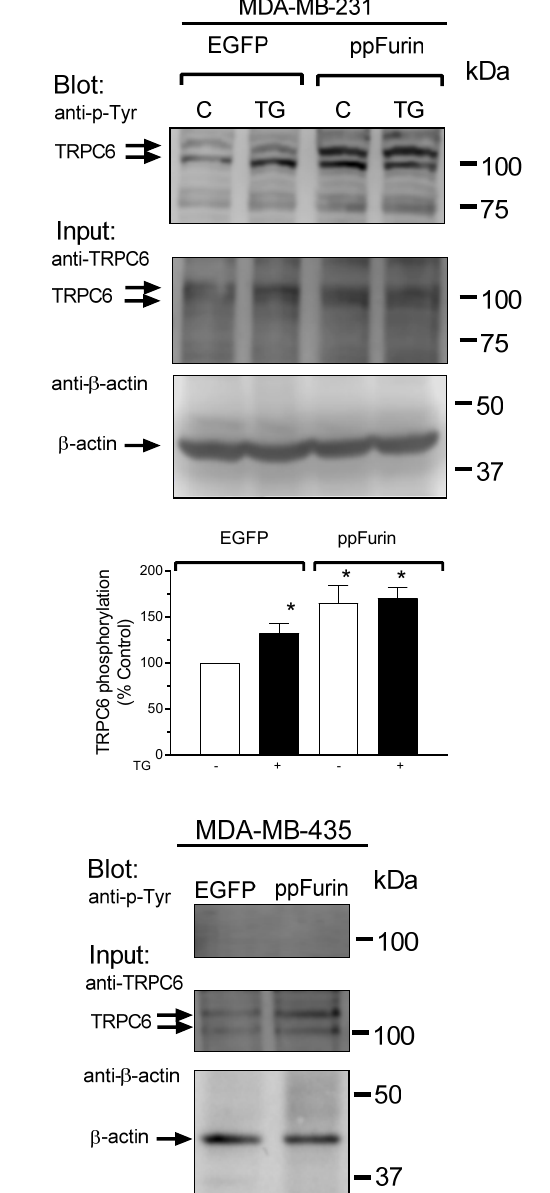
Figure 6. ppFurin induces TRPC6 tyrosine phosphorylation in MDA-MB-231 cells. ( a ) Control and ppFurin-expressing MDA-MB-231 cells were stimulated with 1 µ M of TG for 3 min or left untreated and lysed. Whole cell lysates were immunoprecipitated (IP) with anti-TRPC6 antibody. Immunoprecipitates were analyzed by Western blotting using a specific anti-phosphotyrosine antibody and later, protein loading control was carried out by the reprobing of the membrane with the anti-TRPC6 antibody used for immunoprecipitation. Blot images show results representative of five experiments. Bar graphs represent the quantification of TRPC6 tyrosine phosphorylation in resting and TG-treated cells. Results are presented as percentage of control (cells transfected with pIRES2-EGFP empty vector and not stimulated with TG) and expressed as mean ± SEM. Statistical significance was assessed by one-way analysis of variance combined with the Dunnett post hoc test and * represents p < 0.05 as compared to control. ( b ) Control and ppFurin-expressing MDA-MB-435 cells were lysed and whole cell lysates were immunoprecipitated (IP) with anti-TRPC6 antibody. Immunoprecipitates were analyzed by Western blotting using a specific anti-phosphotyrosine antibody, and later, protein loading control was carried out by the reprobing of the membrane with the anti-TRPC6 antibody used for immunoprecipitation. Blot images show results representative of five experiments.